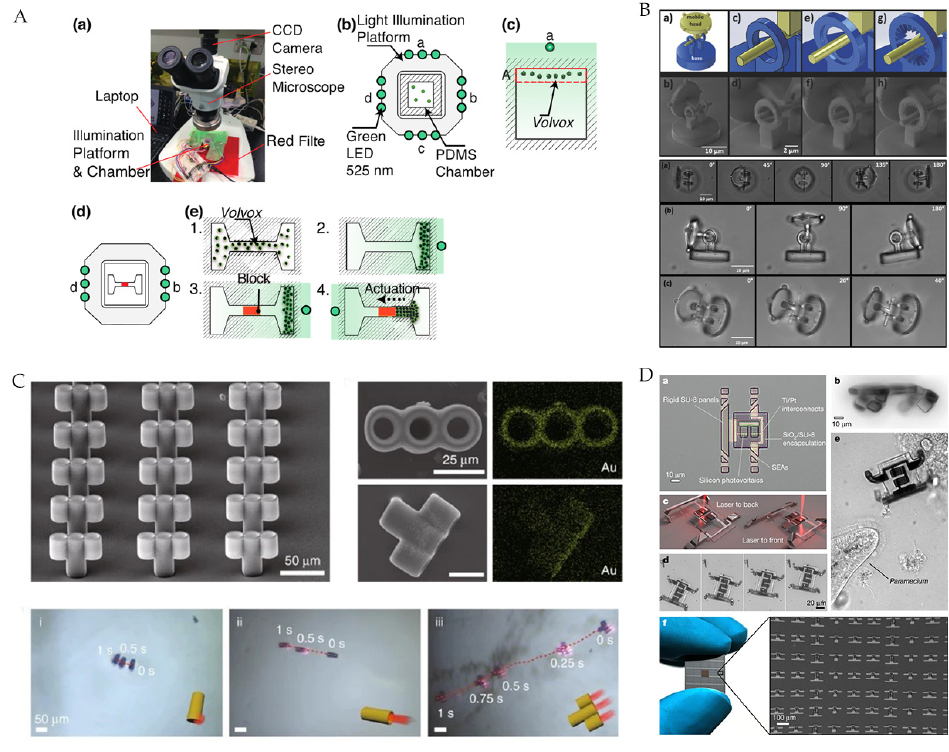
Figure 3. ( A ) Light-induced motion and equipment for phototactic algae. Reproduced with permis- sion from [30]; published by MDPI, 2019. ( B ) Light-radiation pressure-actuated hinged microrobot. Reproduced with permission from [11]; published by John Wiley and Sons, 2017. ( C ) Photothermally actuated microbar robot. Reproduced with permission from [13]; published by Springer Nature, 2020. ( D ) Electronically integrated and mass-manufactured photoelectrically actuated microrobot. Reprinted by permission from ref [37]. Copyright 2020 Springer